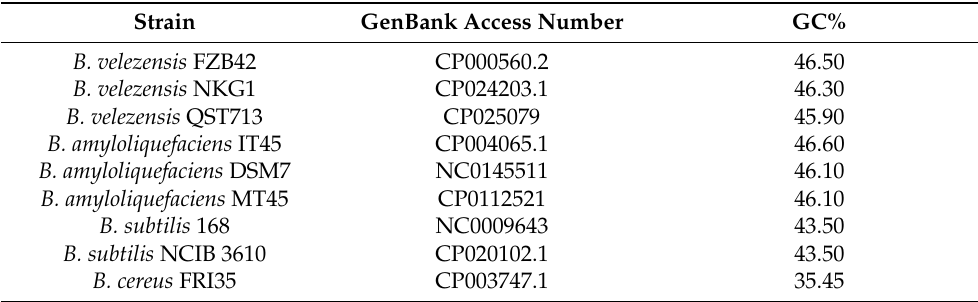
Table 1. Characteristics and accession number of the genomes used as reference in the comparative